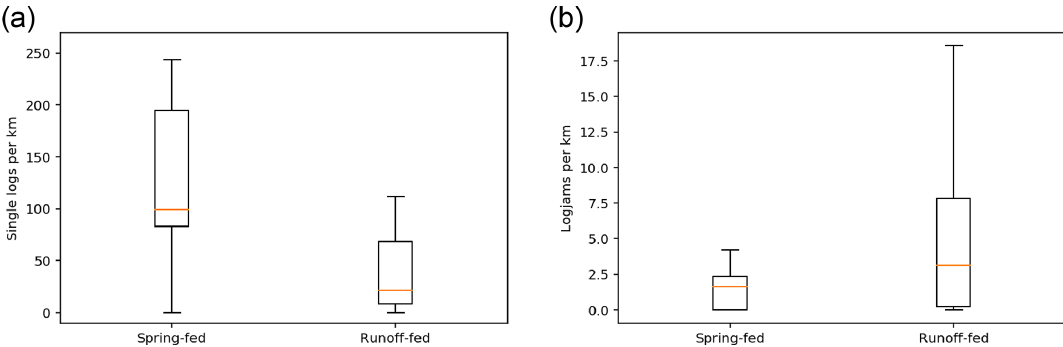
Figure 4. Boxplot representing the number of (a) single logs and (b) logjams identified per kilometer via satellite imagery on spring-fed and runoff-fed streams. Table 2. Fit statistics for candidate models for spring-fed and runoff-fed streams. Adjusted R 2 and Akaike’s information criterion (AICc) account for the number of predictive variables. A larger R 2 value indicates better fit, while a smaller AICc value indicates that less information is lost. The AICc probability is the likelihood that a given model is the best model based on the criterion of lost information as measured by AICc. The results from adjusted R 2 match very well with the AICc results in ranking. For both runoff-fed and spring-fed streams, we note that models 3–5 are essentially identical when fit for all streams since parameters a and c in model 5 are indistinguishable from those in model